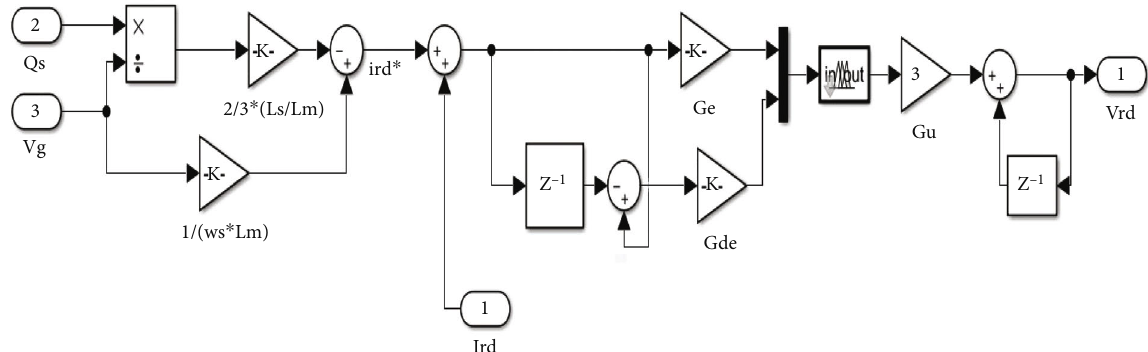
Figure 12: PI – FLC for the stator reactive power in MATLAB Simulink.